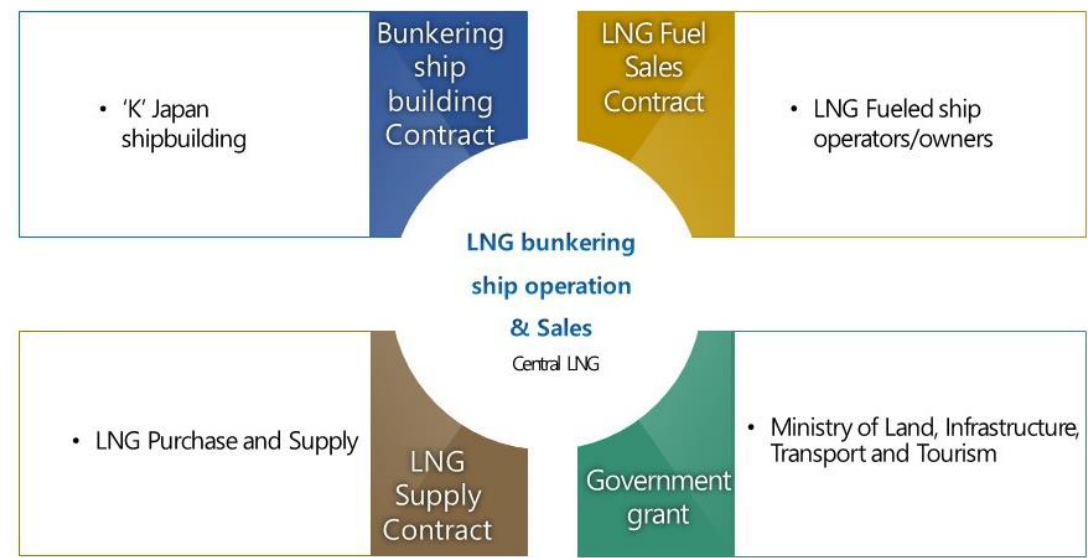
Figure 3. LNG bunkering ship operation chain in Japan. Source: Re-edited by author based on data from https://central- lng.com/en/ (accessed on 31 January 2021) [14].